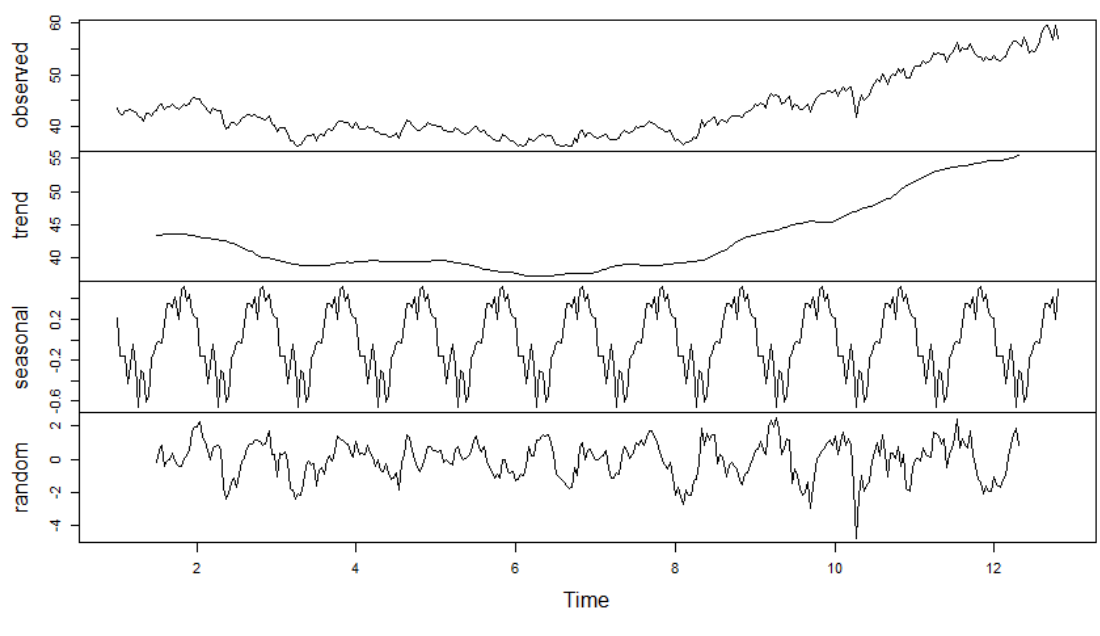
Figure 1. Decomposition of Aurubis stock